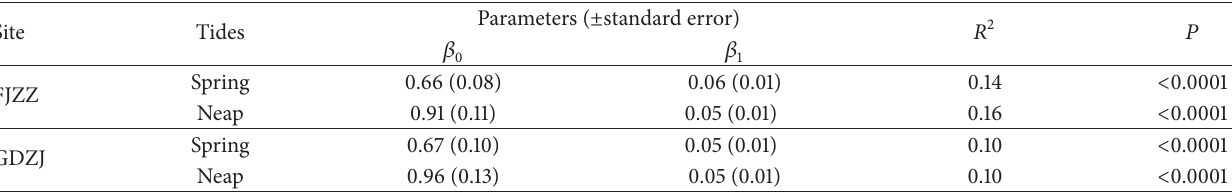
Table 3: Parameters and 𝑅 2 values for the average nighttime NEE fitted to soil temperature (see (3) in the text) on the chosen spring and neap days of the year 2010 at two mangrove study